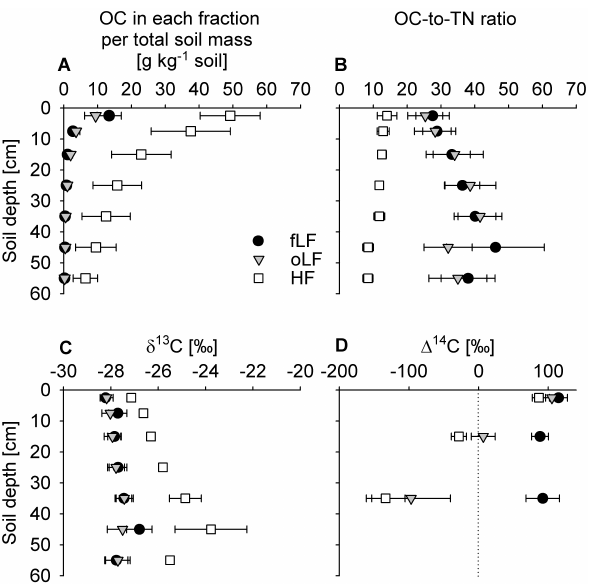
Fig. 1. Depth profiles of average (A) masses of OC in the fLF (free light fraction), oLF (occluded light fraction) and HF (heavy frac- tion) per kg soil, (B) OC-to-TN-ratios of fractions, (C) δ 13 C of OC in fractions, and (D) 1 14 C values of OC in fractions of unploughed sites (Hainich, Hesse, Sorø, Bugac, Laqueuille, Norunda). As C4 grasses occurred at the grassland site Bugac it was excluded from the average of δ 13 C values. Error bars are standard errors ( n = 6 except for δ 13 C n = 5). Wetzstein was not included because of dif- ferent depth increments analysed (see Supplement Fig.